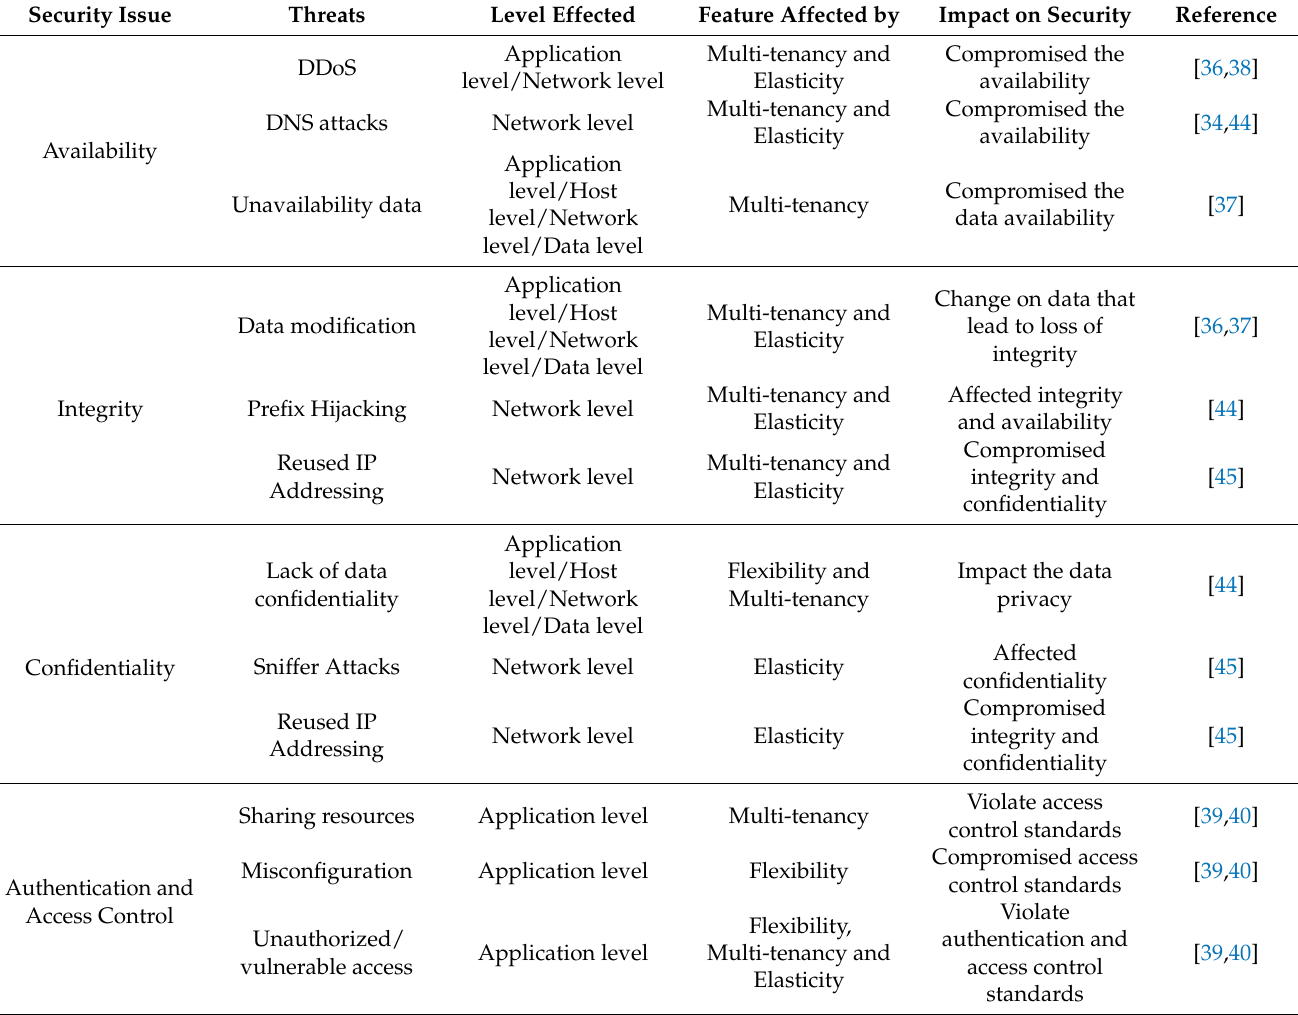
Table 3. Summary of security